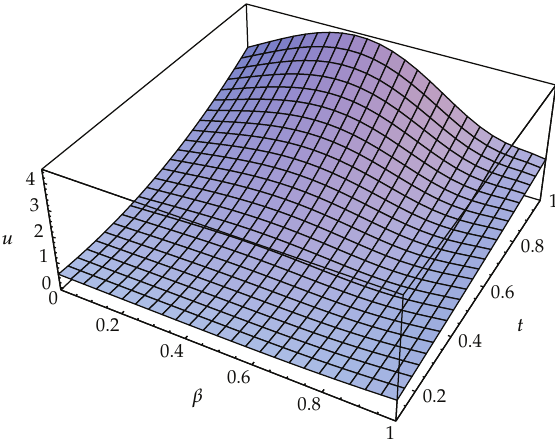
Figure 1: The surface of second-order approximate solution of (cid:2) 3.12 (cid:3) when x (cid:9) 0 . 8, α (cid:9) 1.